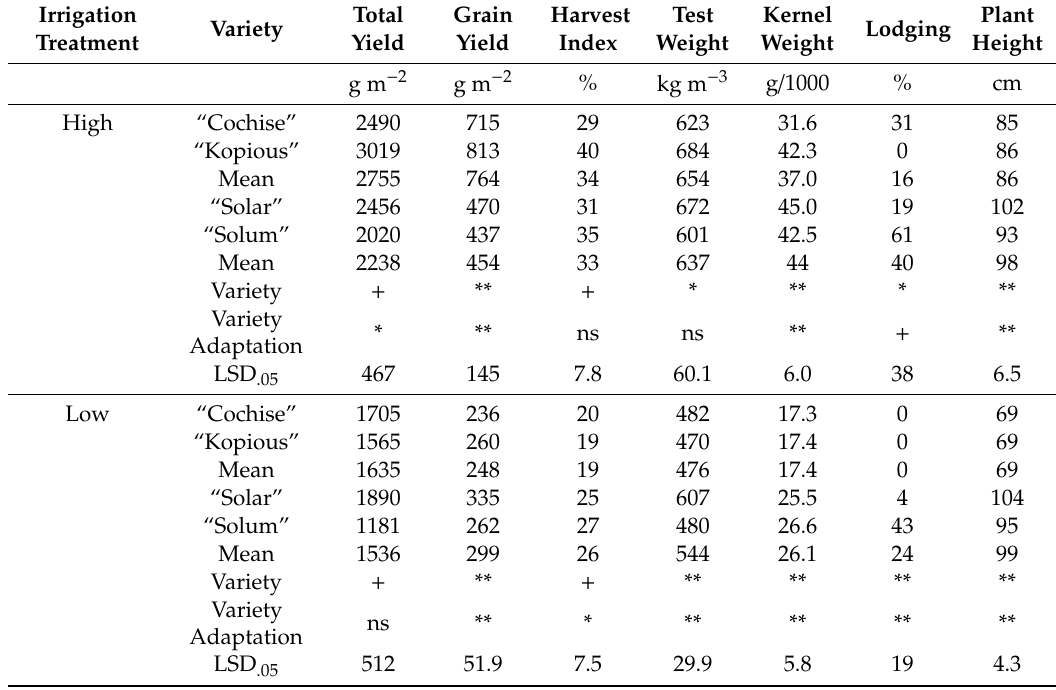
Table 6. E ff ect of irrigation treatment on barley yield and yield components for a trial conducted in Tucson in 2015. Total Grain Irrigation Variety Yield Yield Treatment